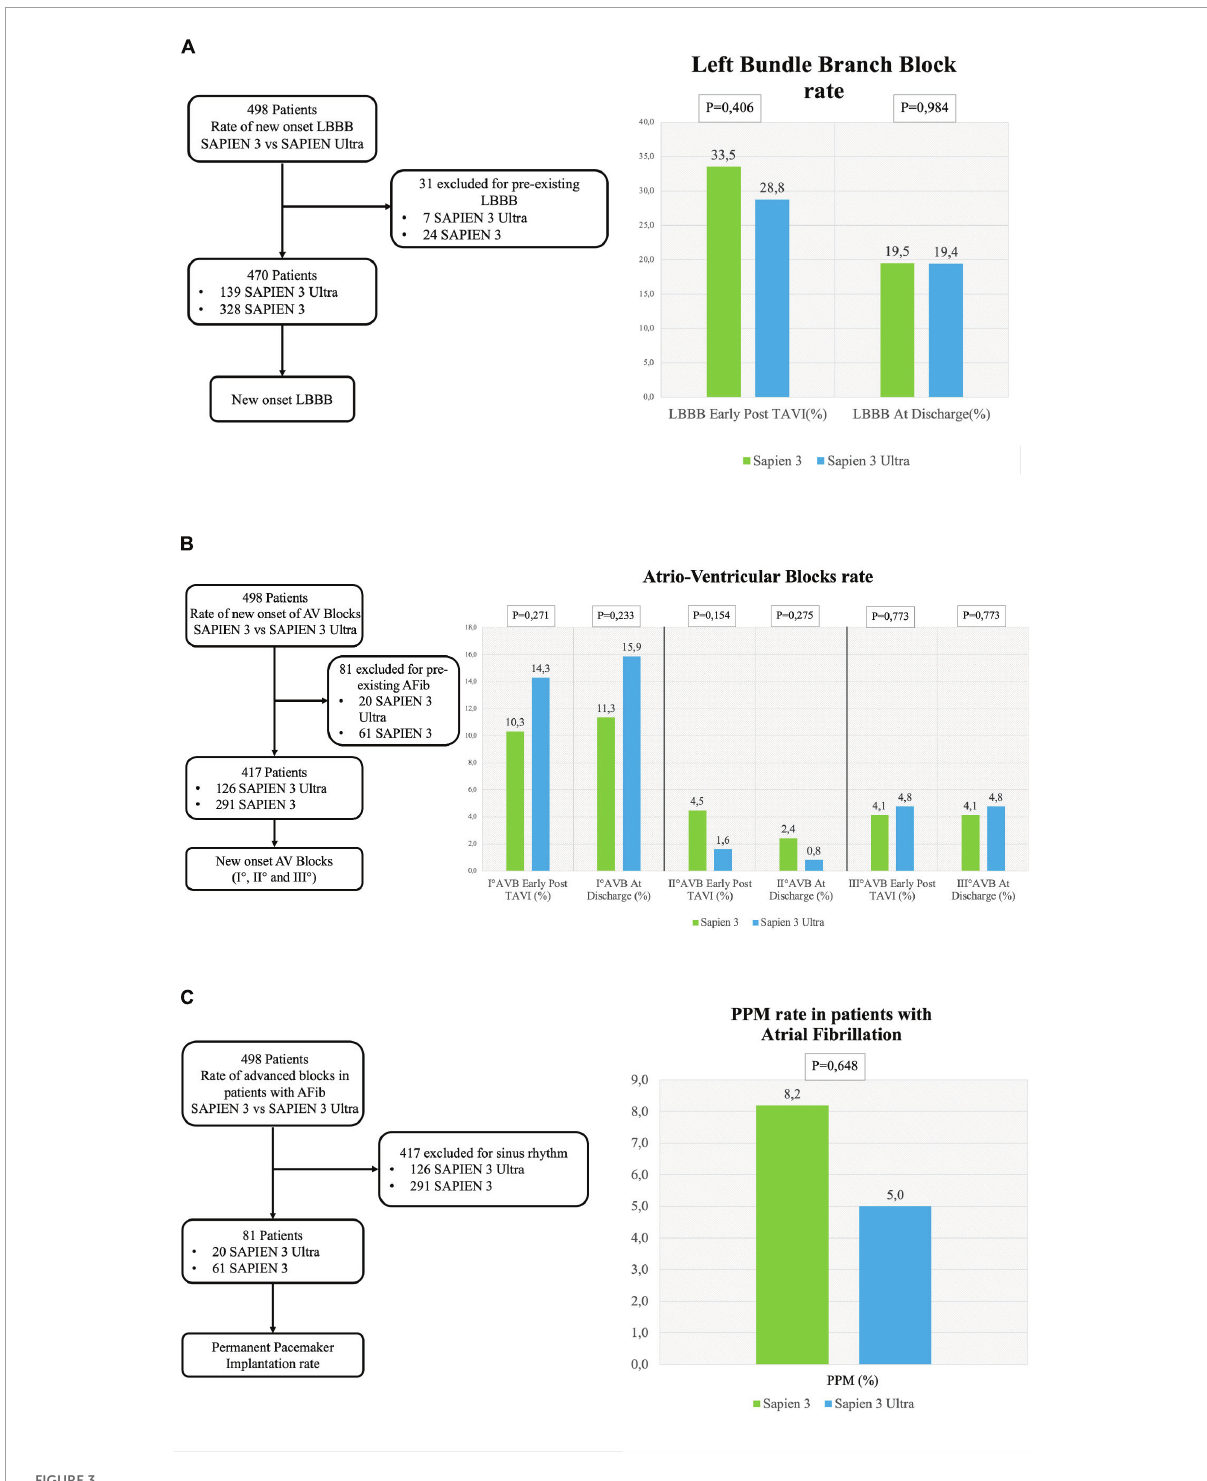
FIGURE3 Conduction disorders subanalysis. (A) Left flowchart of the analysis for the rate of new-onset LBBB. Patients with pre-existing LBBB were excluded. (A) Right left bundle branch block (LBBB) rate early after TAVI and at discharge. (B) Left flowchart of the analysis for the rate of new-onset AV blocks. Patients with pre-existing atrial fibrillation were excluded. (B) Right rate of I ◦ AV block early after TAVI and at discharge (right graph), II ◦ AV block rate early after TAVI and at discharge (central graph) and III ◦ AV block early after TAVI at discharge (left graph). (C) Left flowchart of the analysis for the rate of permanent pacemaker (PPM) implantation in patients with atrial fibrillation. Patients with sinus rhythm were excluded. The graph shows the rate of PPM